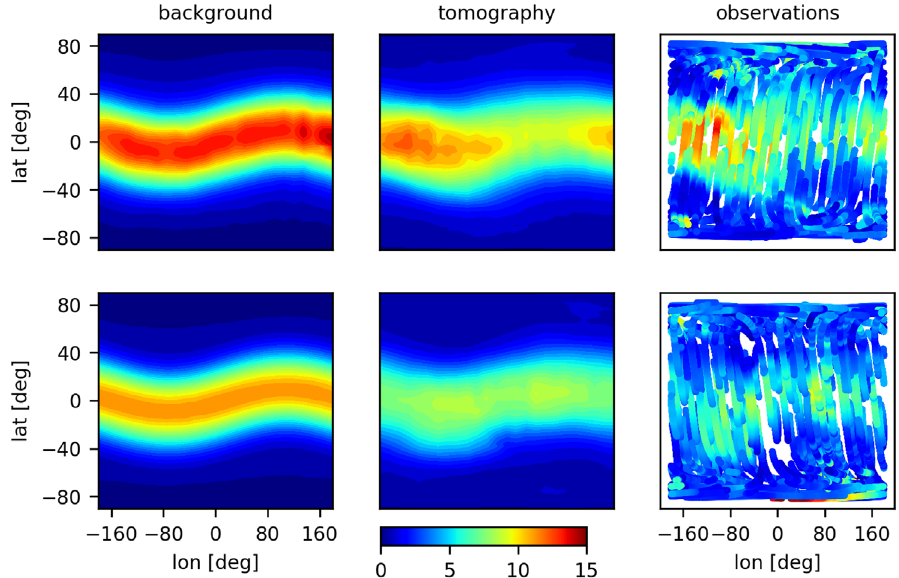
Fig. 3. Comparison between VTEC maps obtained with the developed tomography, background, and used METOP observations (DOY 076/ 2015). Images of the top panel are related to the METOP orbit rising phase and in bottom panel are related to the METOP orbit setting phase. The unit of the color bar is